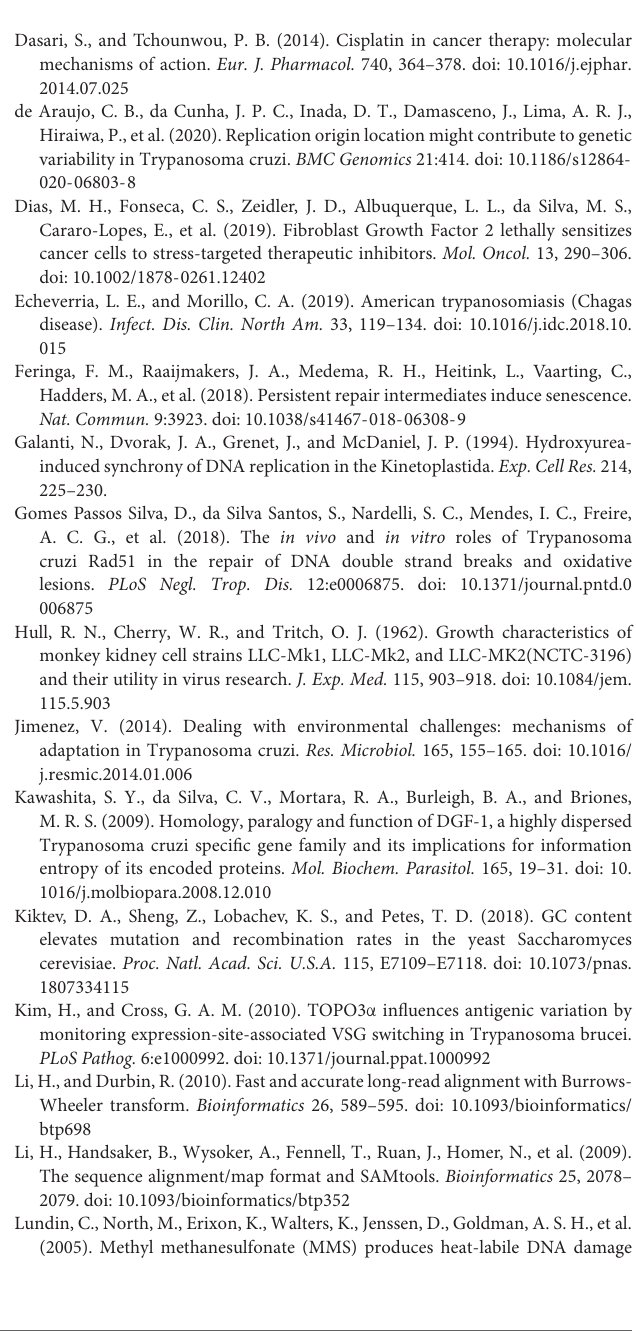
Supplementary Figure 10 | Telomere length analysis by Southern blot. (A) Purified probe containing telomeric sequences repeat (TTAGGG) ∼ 50 was generated by pTEL plasmid digestion with HindIII restriction enzyme. (B) Southern blot analysis of telomeric sequence-containing fragments generated by digestion of genomic DNA with restriction enzymes CviQI, HpaII, AluI, and HhaI; genomic DNA from WT and TcTopo3 α KO cells was analyzed. Ethidium bromide-stained agarose gel showing the digestion products that were further analyzed by Southern blot. Right panel represents quantification of signal intensities for telomere hybridization using ImageJ software. Signals were plotted against DNA size (Kb). Supplementary Figure 11 | Venn diagram of the SNPs in the MMS1, MMS2, NT1, and NT2 isolates. Venn diagram depicting the sharing of the SNP positions in the four T. cruzi evaluated